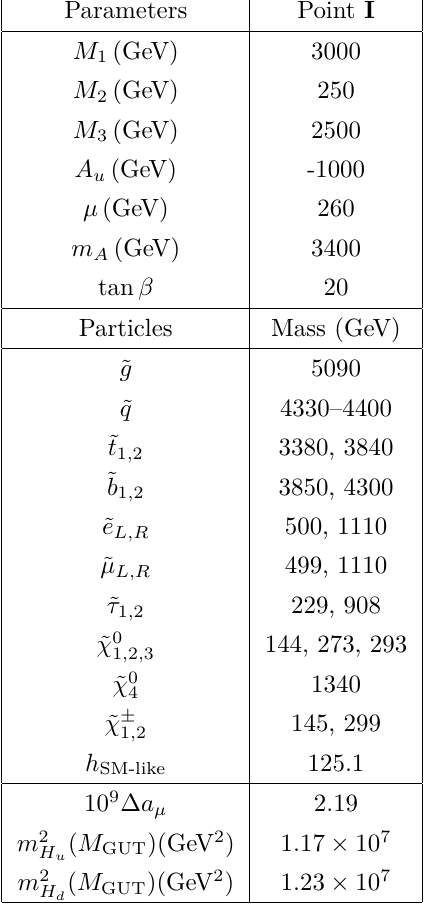
= M N = M N = 10 9 1 2 3